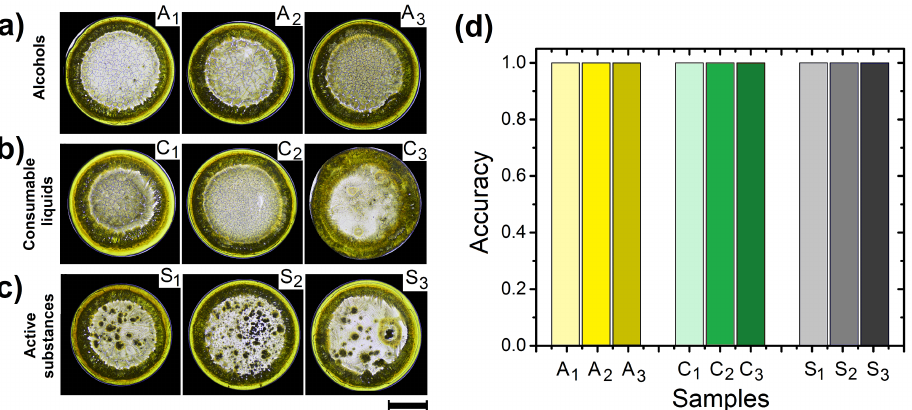
Figure 7. Recognition of Methotrexate containing different substances Patterns in dried droplets of Methotrexate/NaCl produced by the addition of 10% of ( a ) alcohols (ethanol( A 1 ), methanol( A 2 ), and isopropanol( A 3 )), ( b ) consumable liquids (rehydrating serum( C 1 ), carbonated drink( C 2 ), and liquid detergent ( C 3 )), and ( c ) medicines (Folic acid( S 1 ), Diclofenac ( S 2 ), and Acetaminophen( S 3 )). The relative concentration of the three medicines and Methotrexate in the final sample is 1:10, w / w . The control parameters in pattern formation from the evaporation of droplets were: T s = 63 ◦ C, and RH = 25%. The black line indicates 1 mm. ( d ) The corresponding Accuracy for the three groups of substances based on the entropy of the entire